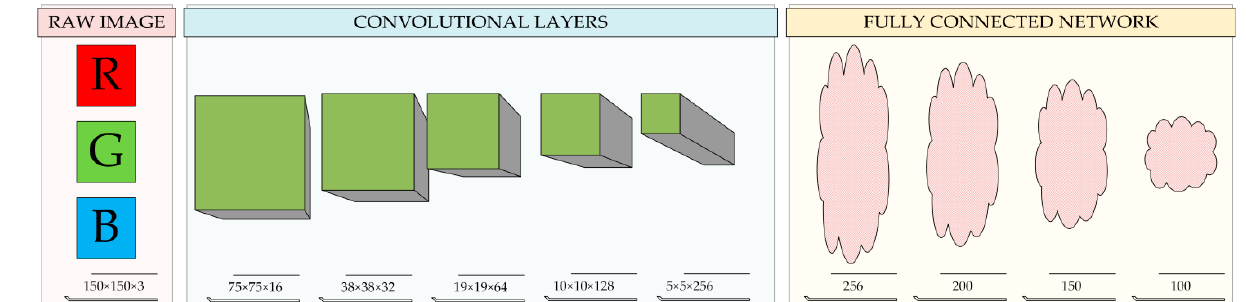
Figure 14. Structure of deep neural network image classifier.